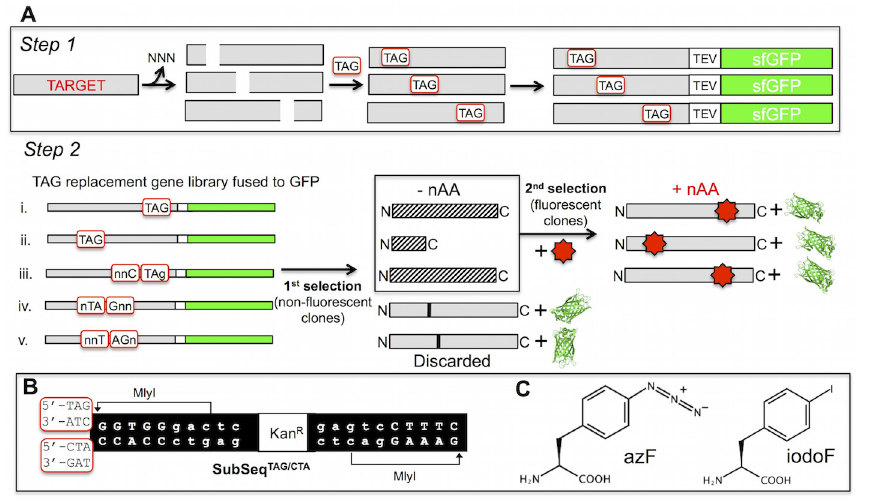
Fig 1. In-frame TAG codon replacement. (A) Step 1 involves trinucleotide deletion followed by TAG donation using a combination of the engineered transposon MuDel [25] and the DNA cassette SubSeq [21] essentially as described previously [23] and outlined in B. The TAG substitution library is then cloned in front of the TEV-sfGFP cassette in plasmid pIFtag (S1 Fig). Step 2 outlines the selection for in-frame TAG substitutions. Initially, cells are grown in the absence of a nAA and non-fluorescent colonies selected; fluorescent colonies are removed at this stage as they are deemed not to have an in-frame TAG due to the generation of a full translation product. The second selection involves plating the selected colonies in the presence of nAA. Those cells that regain fluorescence suppress TAG termination due to nAA incorporation and thus produce sfGFP. (B) Alternate versions of the new SubSeq DNA cassette for donating TAG. The two alternatives are shown in the red boxes at the far left. (C) The two nAAs used in this study, p